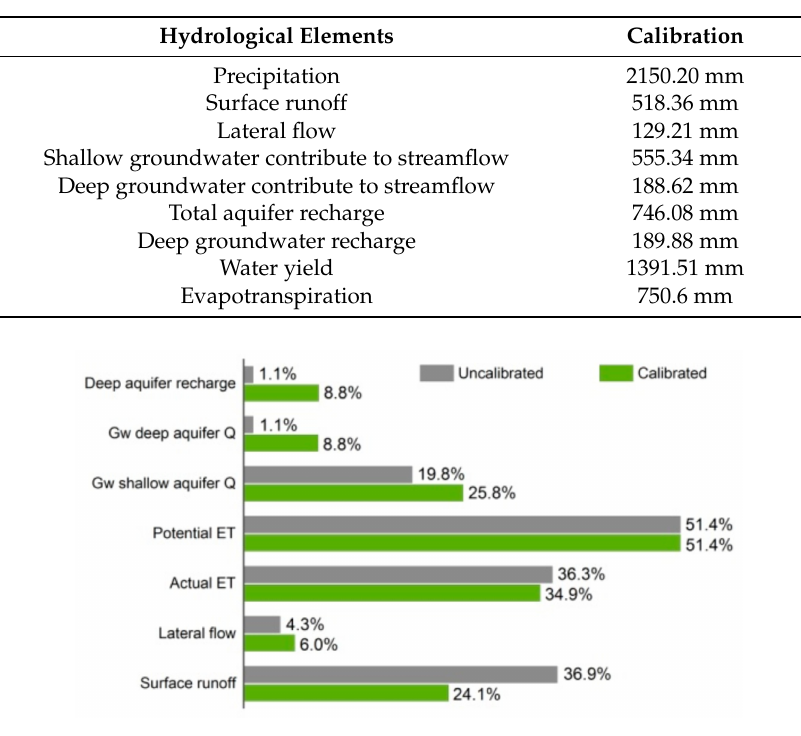
Table 5. Average annual contribution by the hydrological elements to the water budget.